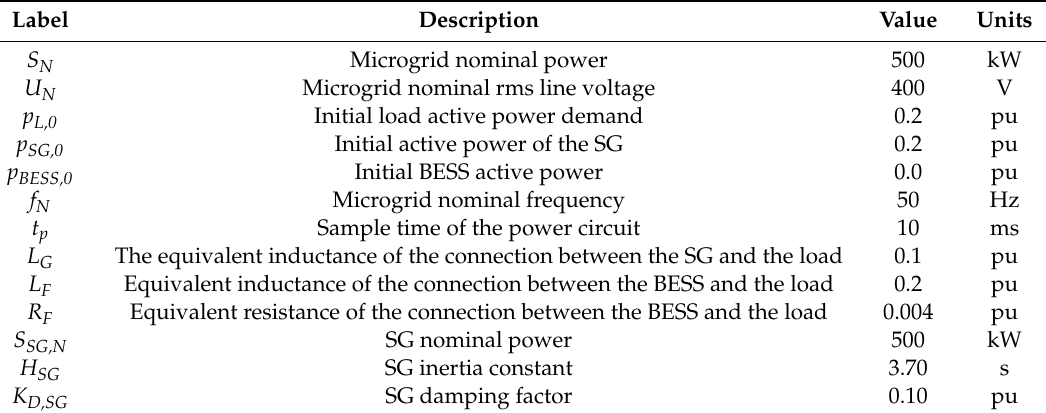
Figure 9. Test system: MG case study. SG: Synchronous generator. Table 1. Electrical parameters of the test system